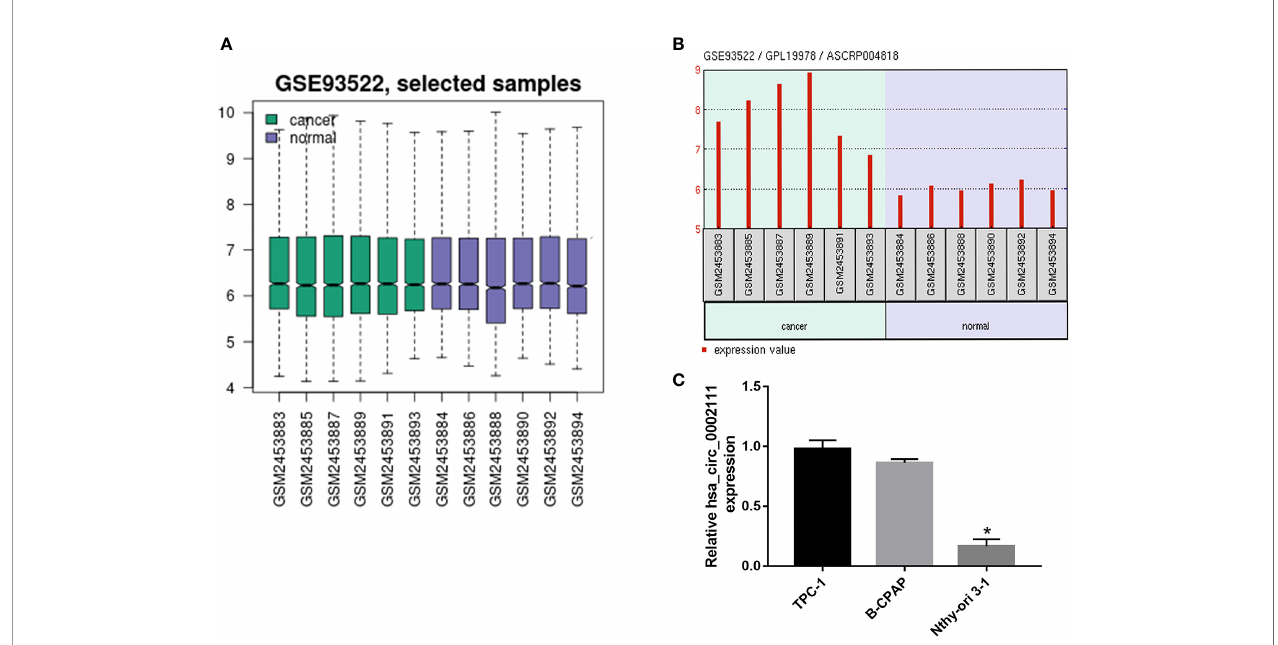
FIGURE 1 | Circular RNA (circRNA) expression pro fi le in papillary thyroid cancer (PTC). (A) Box plot showed the normalized intensities from the tumor and non- tumor tissue samples (B) Gene Expression Omnibus dataset, GSE93522, showed that hsa_circ_0002111 was signi fi cantly increased in tumor tissues compared to that in non-tumor tissues. (C) Quantitative real-time polymerase chain reaction (qRT-PCR) veri fi cation of the expression of hsa_circ_0002111 in TPC-1, B-CPAP, and Nthy-ori 3-1 cell lines. *P <